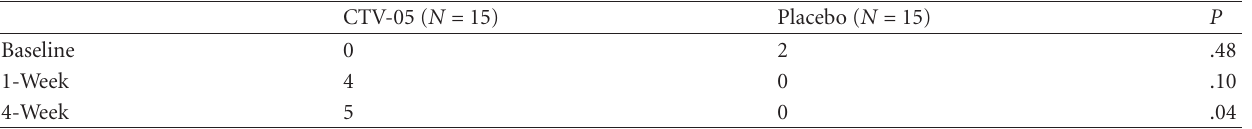
Table 3: Subjects with pyuria ∗ at follow-up clinic visits.